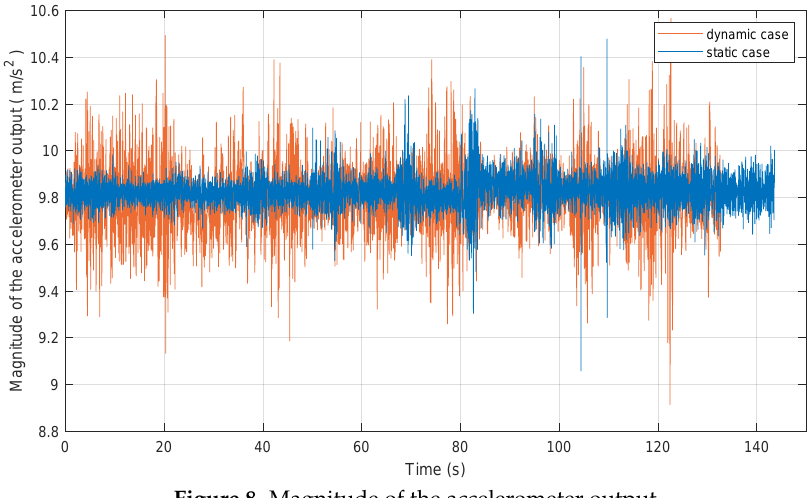
Figure 8. Magnitude of the accelerometer output.